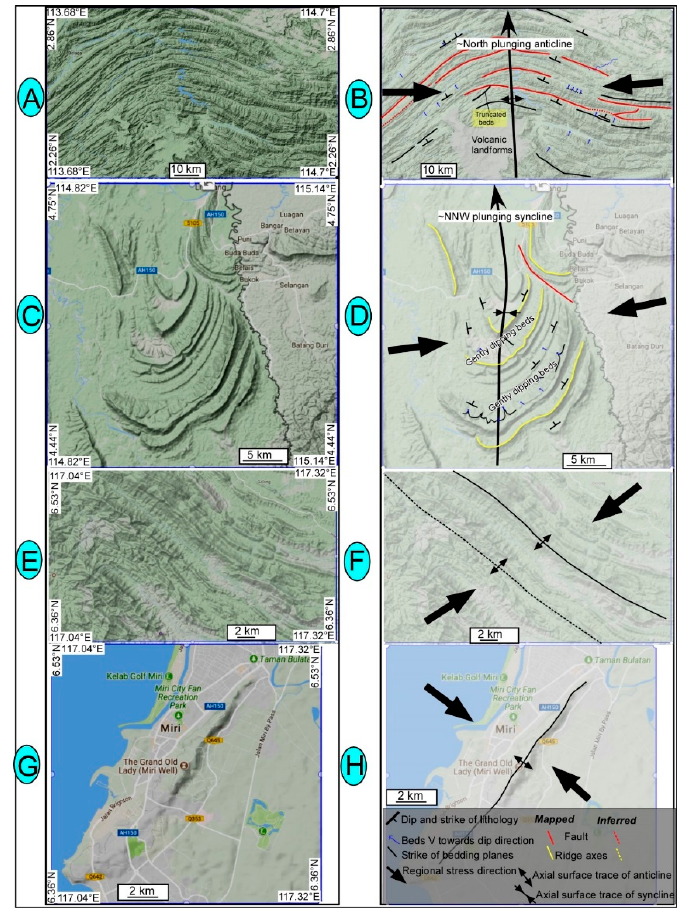
Figure 12. Un-interpreted Google satellite terrain images are shown on the left and evidence of folding is shown on the right. Broadly, two major folding events are recorded by the folded rocks, and these are associated with ~NNW-SSE ( A – D ) to ~NW-SE ( E , F ) and ~NE-SW ( G , H ) trending fold axes. Some of the folds are truncated by faults and are plunging ~northward ( B , D ). Examples of ~NW-SE ( E , F ) and ~NE-SW ( G , H ) trending fold axes that are controlled by